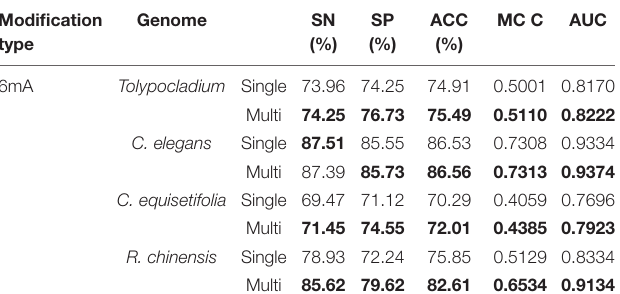
TABLE 3 | Comparison results of the model using the multi-task learning and the model not using the multi-task learning for identifying 6mA